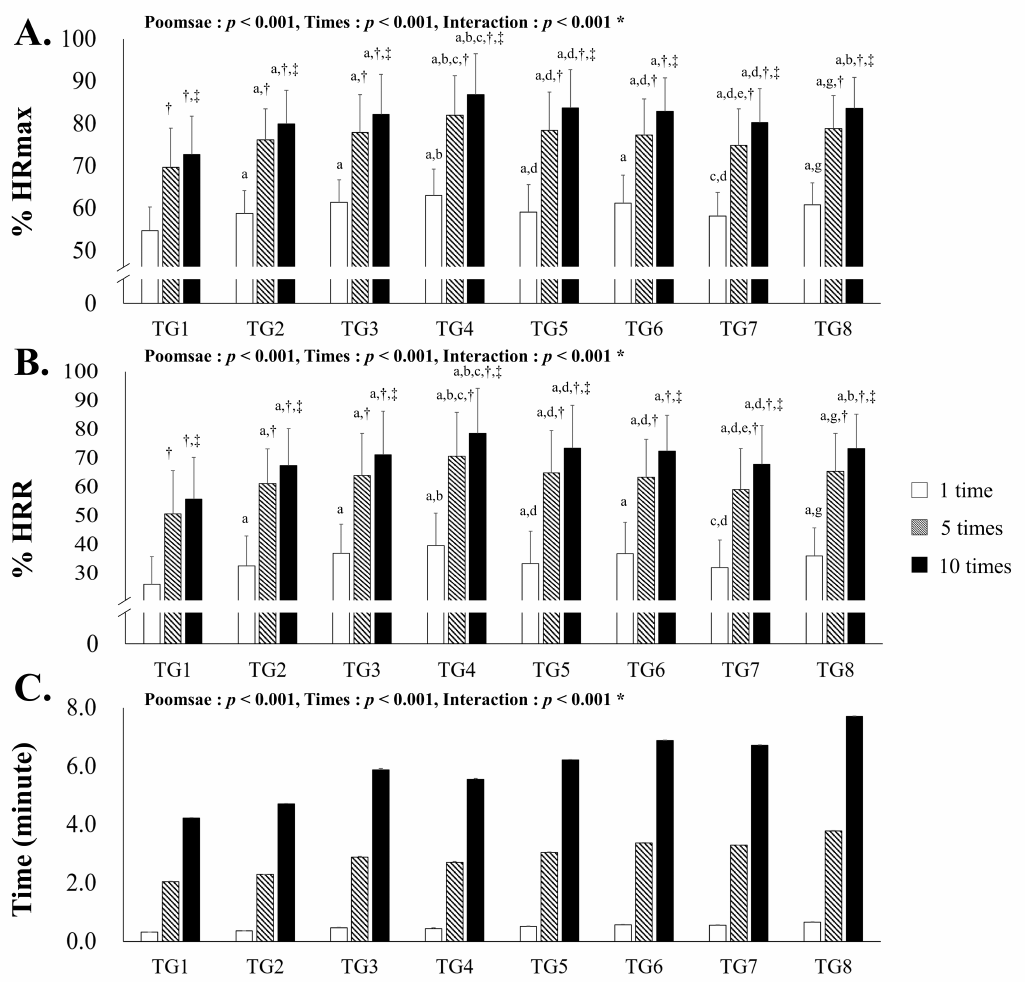
Fig. 5. Taekwondo Taegeuk Poomsae intensity and time (mean ± standard deviation). (A) Change in %HRmax, (B) change in %HRR, (C) change in time are shown. TG, Taegeuk; %HRmax, percentage maximal heart rate; %HRR, percentage heart rate reserve. a: p < 0.05 vs. TG1, b: p < 0.05 vs. TG2, c: p < 0.05 vs. TG3, d: p < 0.05 vs. TG4, e: p < 0.05 vs. TG5, f: p < 0.05 vs. TG6, g: p < 0.05 vs. TG7. †: p < 0.05 vs. 1st repetition, ‡: p < 0.05 vs. 5th